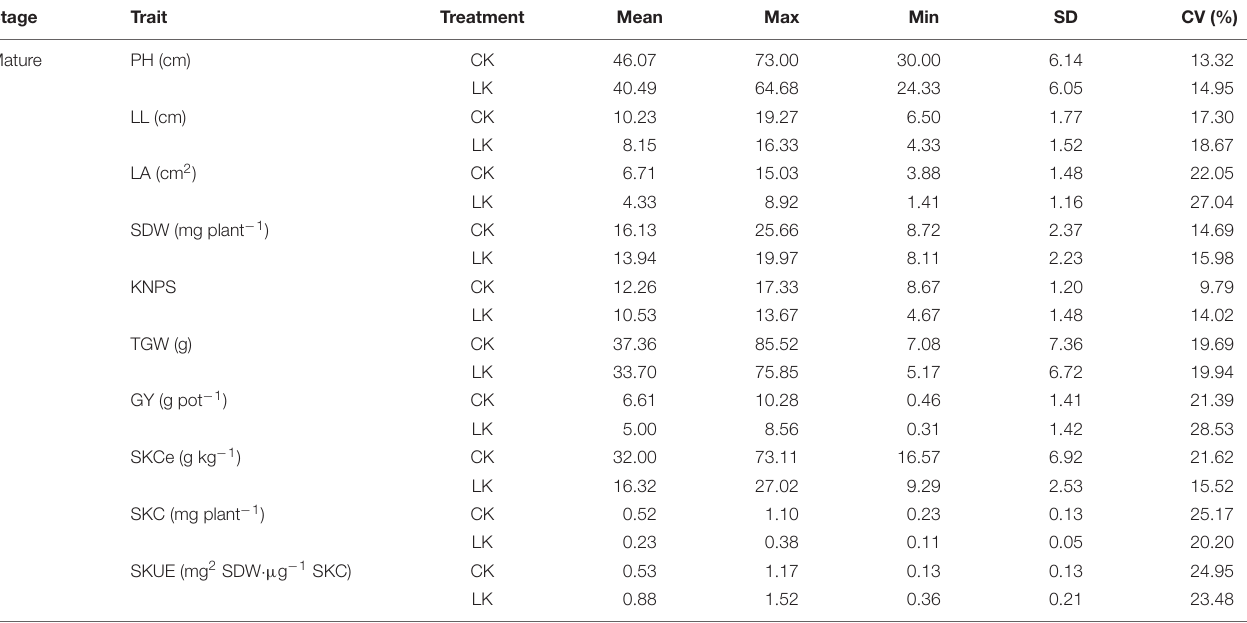
TABLE 2 | Phenotypic variations in the K utilization efficiency-related traits at the mature stage. Stage Trait Treatment Mean Mature